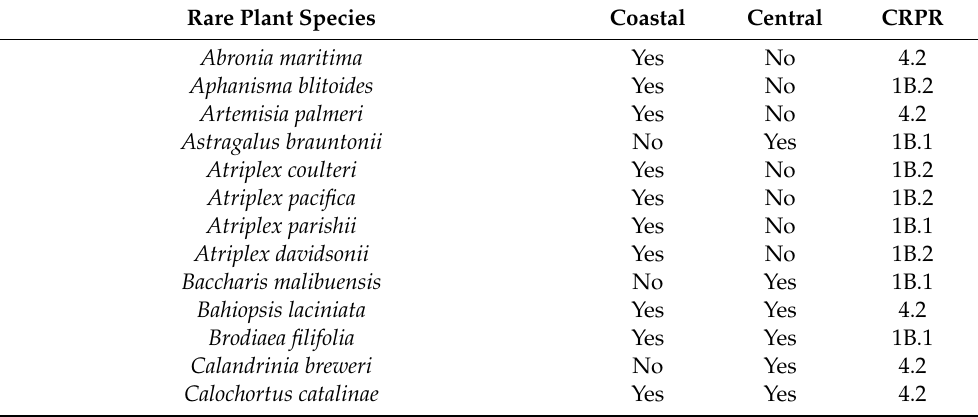
Table A5. Rare plant species ordered alphabetically within the Natural Communities Coalition (NCC) Reserve System and their presence or absence between the two subregions—Coastal and Central—and their California native plant society California rare plant rank (CRPR). Out of the 64 species, 22 species occur in both subregions, 27 species occur only in the coastal reserve, 16 only occur in the central reserve. Helianthus nuttallii ssp. parishii (Parish’s sunflower), which is underlined in the table, is the only species extirpated within the NCC Reserve and is presumed extinct throughout its